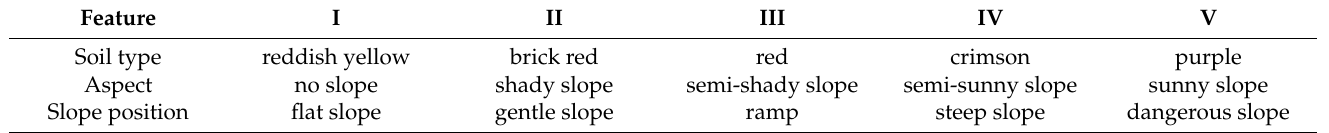
Table 2. Conversion of categorical variables into numerical variables (soil type, aspect, slope